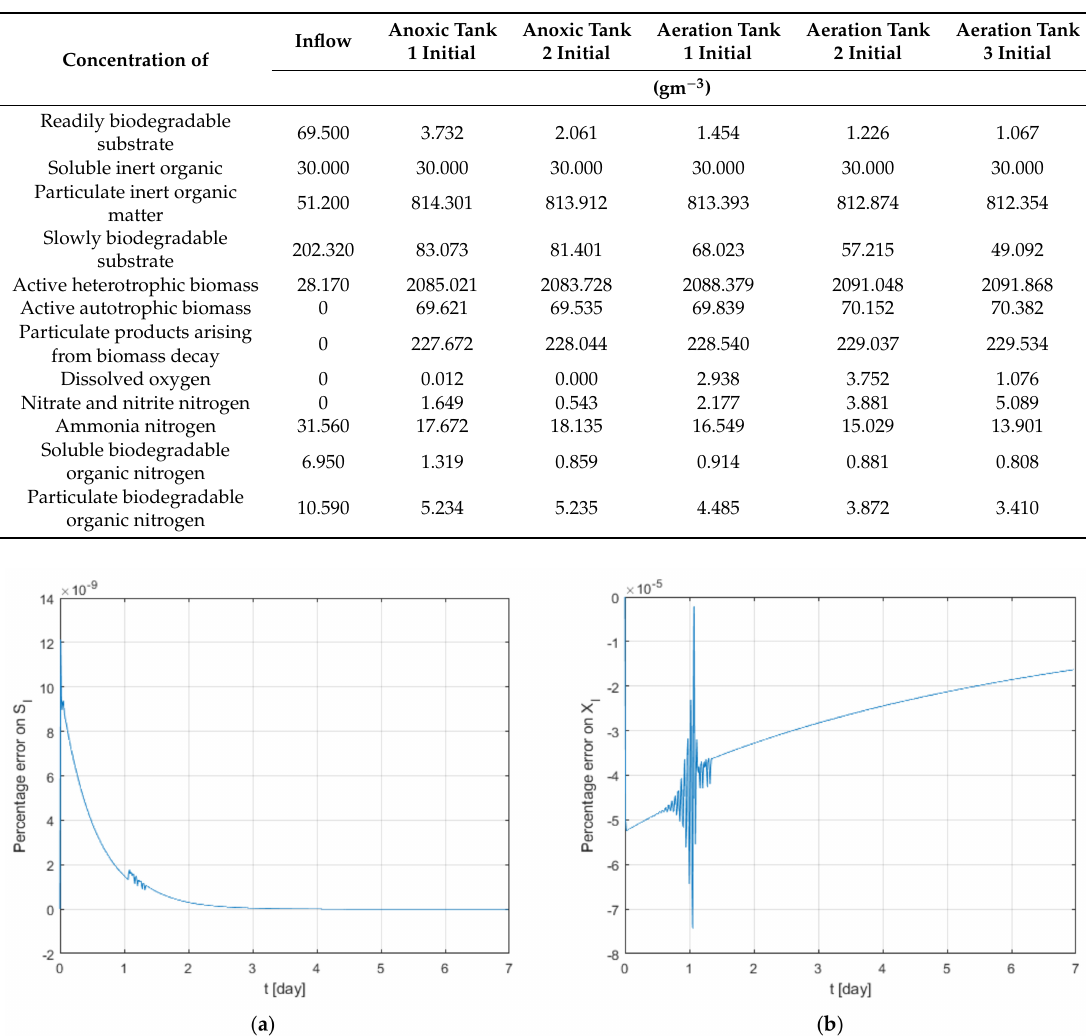
Figure 3. Percentage error in the first anoxic tank on the inert suspended solids ( a ) and on the particulate inert organic matter ( b